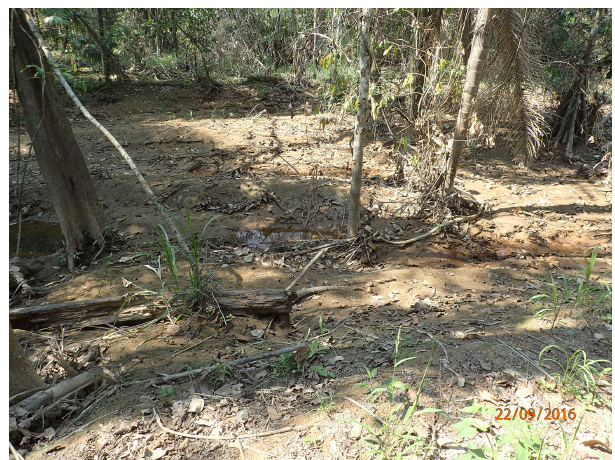
Figure 12. Scouring channels downriver from the logjam in the Tacuaral River in